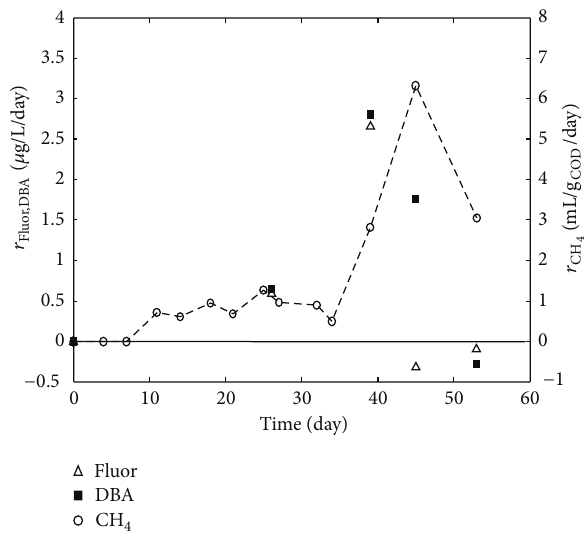
Figure 2: Removal kinetics of Fluor and DBA coupled to methane production kinetic in HLSS reactors (series A). The initial 𝜇 P concentration was measured in duplicate. One reactor was stopped at different sampling